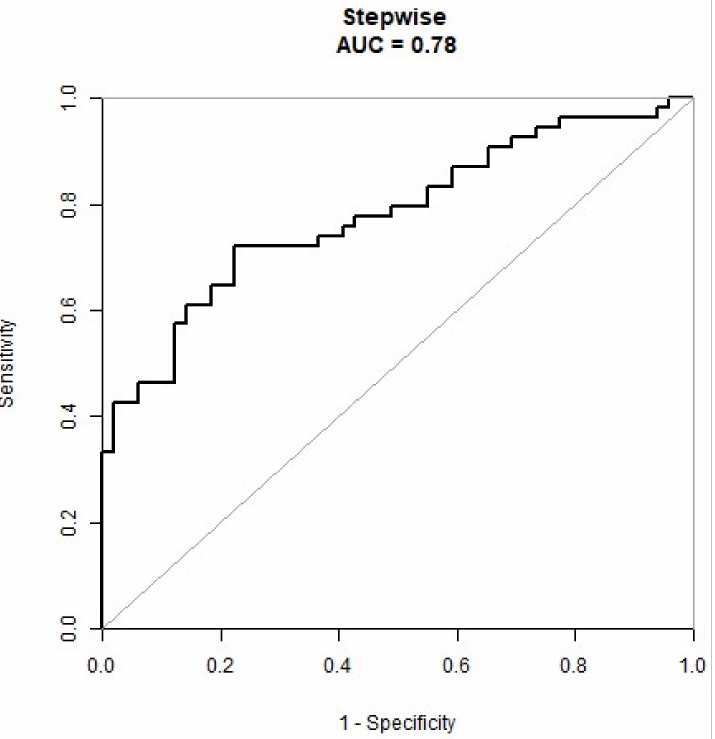
Figure A3. A receiver operating characteristic curve to evaluate the discriminating capability of the nomogram.